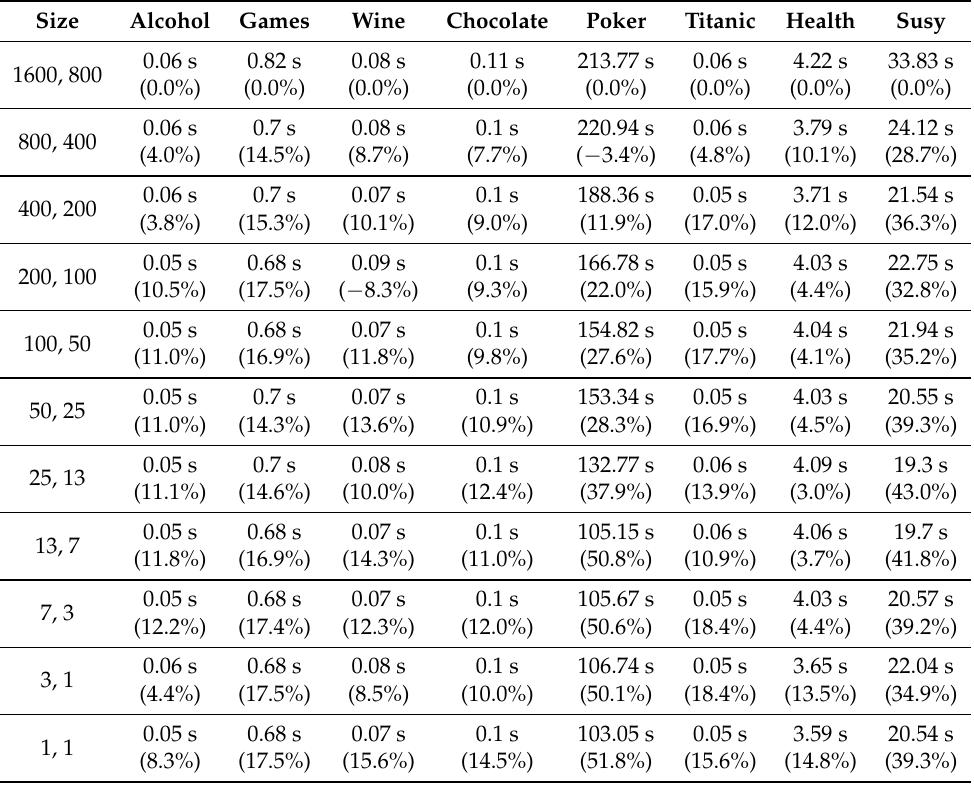
Table 3. Inference times on test set in a similar format to train times. For each dataset we provide the inference time on the test set in seconds followed by the percentage improvement from [1600, 800] in